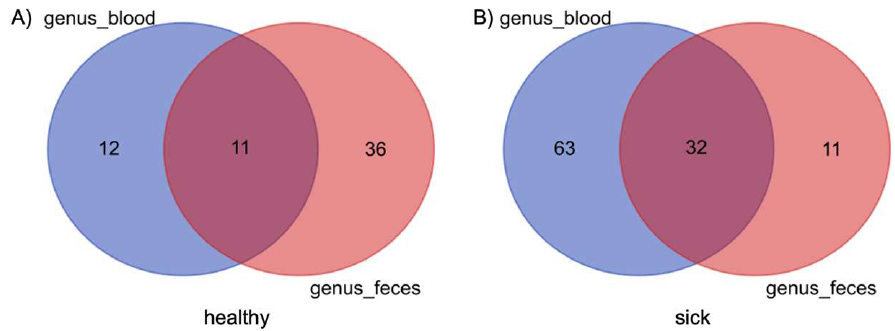
was observed for the relative abundances in the blood of the sick dogs.